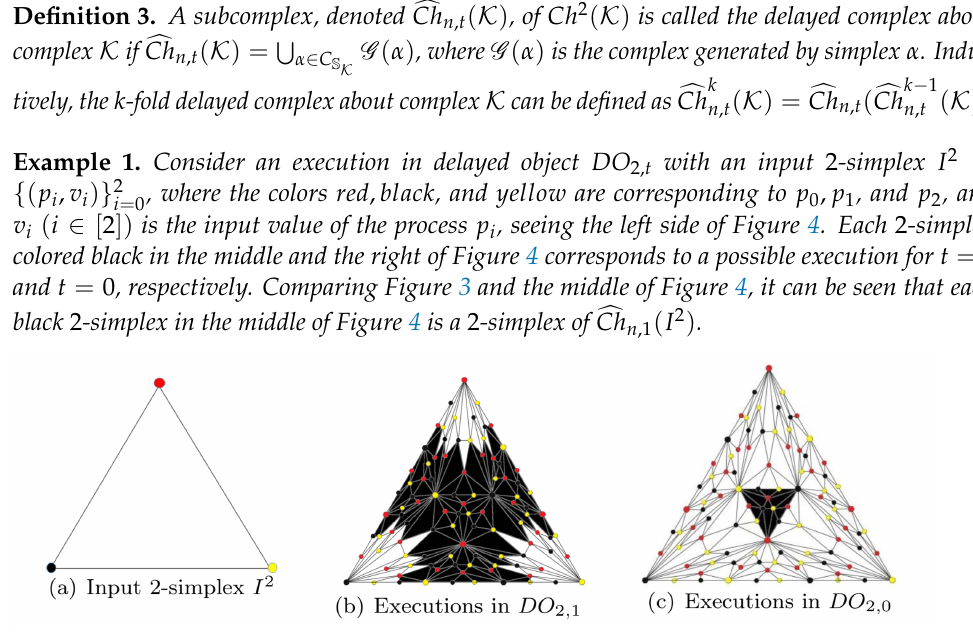
Figure 4. Execution for three processes with input simplex I 2